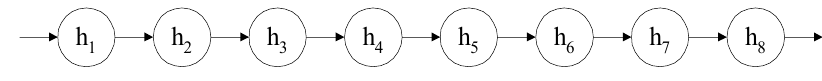
Fig. 1. Track of training system